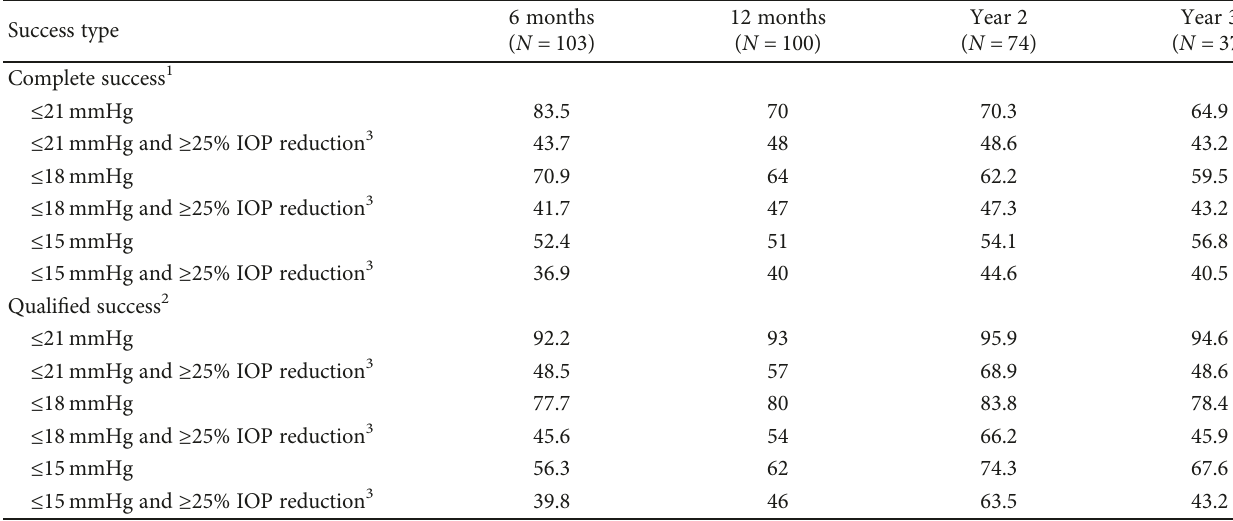
Table 6: Success rates (eyes with canaloplasty only).